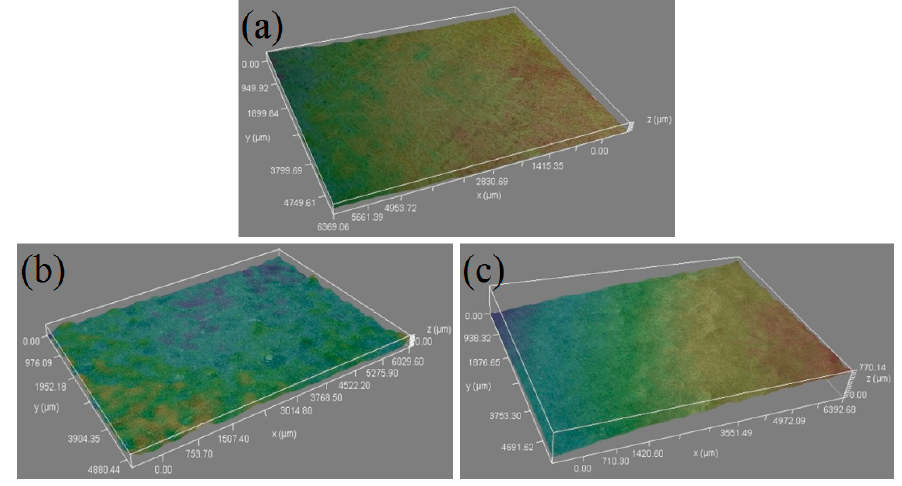
Figure 5. Surface morphologies of three kinds of specimens: ( a ) original TA2, ( b ) 90 min SMAT specimen, and ( c ) 30 min MSP specimen.